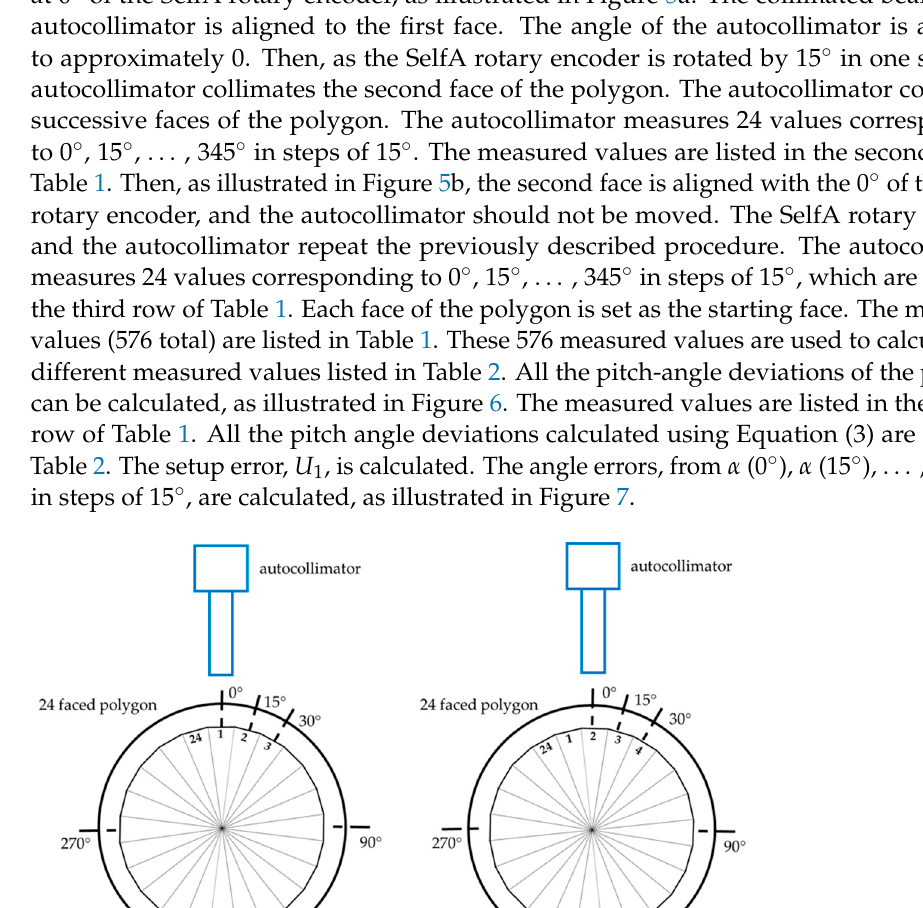
Figure 4. Photograph of the experimental setup.